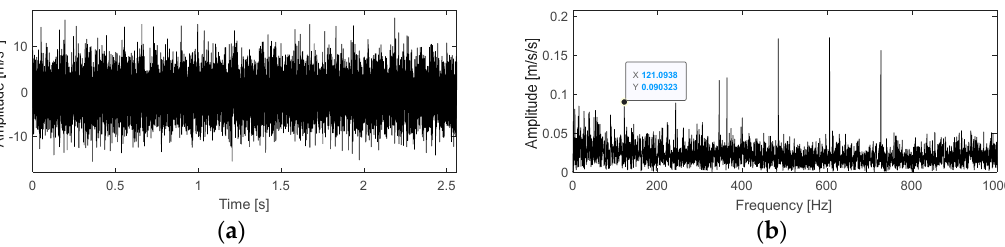
the engineering data; ( b ) Envelope sepctrum of the signal as shown in ( a ). engineering data; ( b ) Envelope sepctrum of the signal as shown in ( a ).